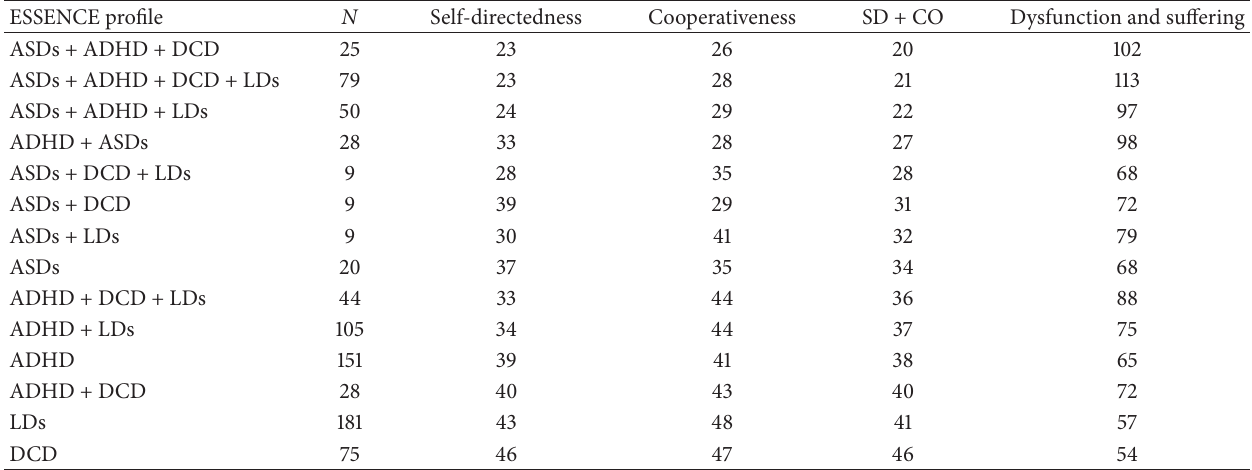
Table 3: Number of individuals and mean (T-scores) in Self-directedness, Cooperativeness, SD + CO, and dysfunction and suffering across ESSENCE